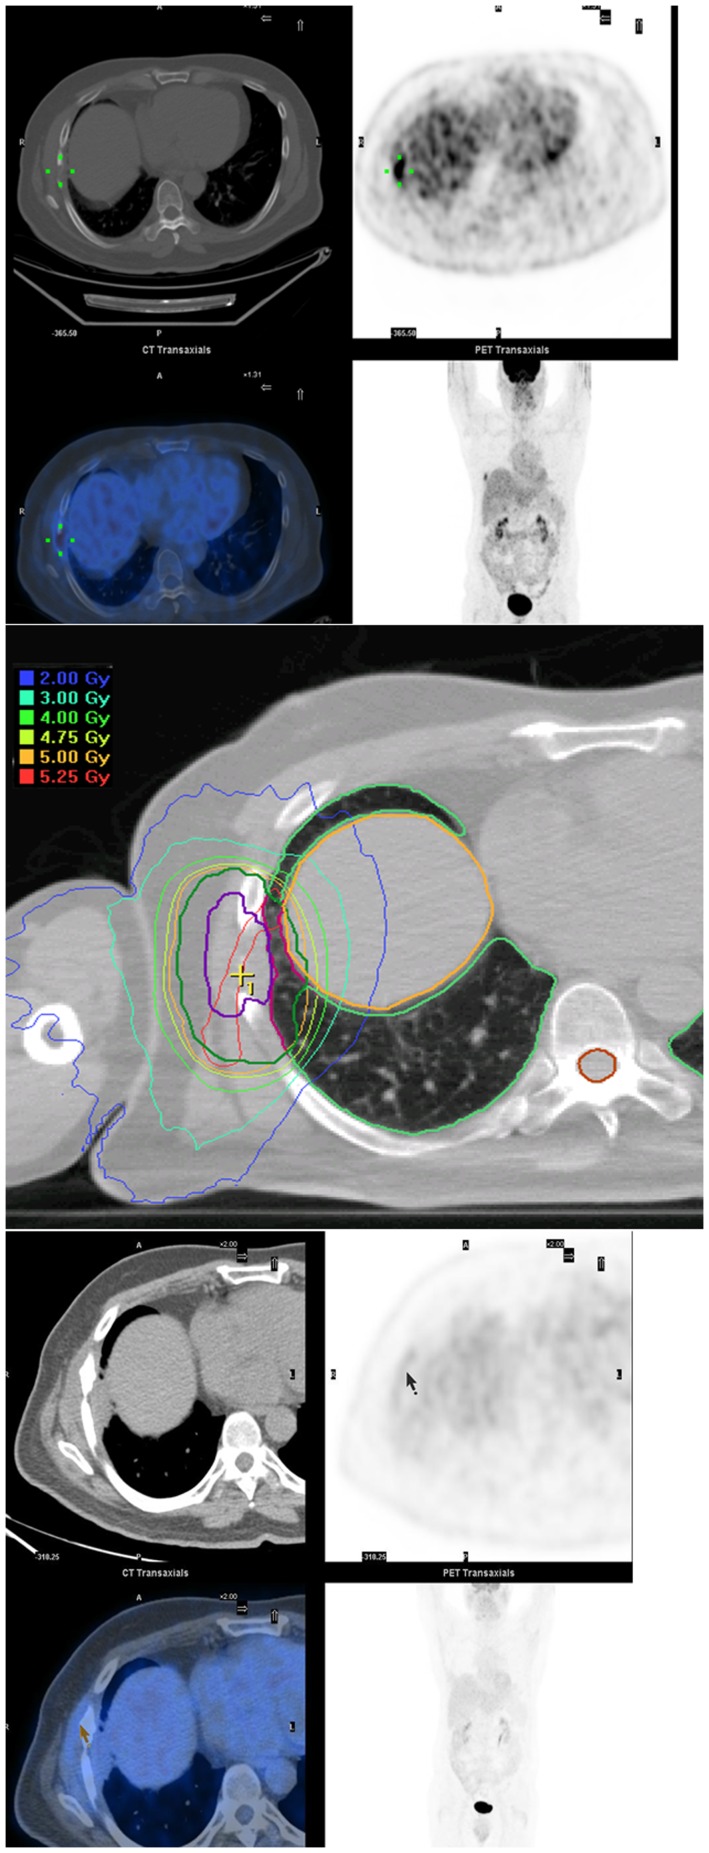
Representative patient treated with concurrent sunitinib and IGRT.a) Pretreatment PET/CT demonstrates a biopsy proven solitary metastasis in the right 7th rib in a patient with non-small cell lung cancer. b) The rib lesion was treated with Novalis using dynamic arcs using the ITV method with an abdominal belt used to dampen respiratory motion. Daily kV imaging was accomplished using bone fusion. There was excellent coverage of the PTV with selective sparing of the normal lung, liver and skin. c) Complete response on PET/CT 23 months after Sutent +RT.